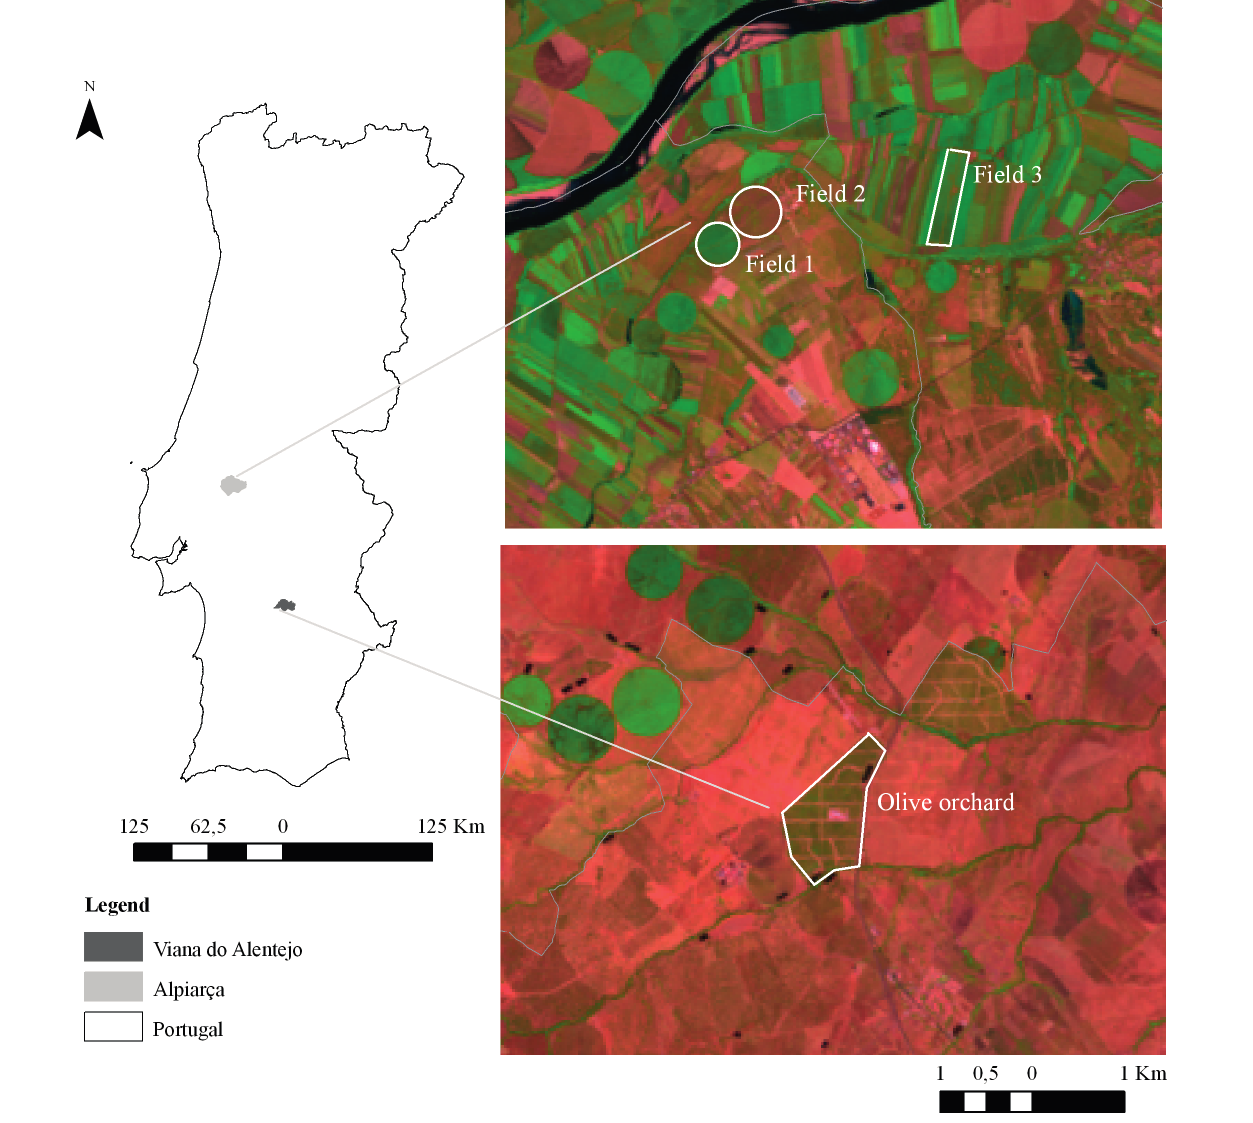
Figure 1. Study areas location in Viana do Alentejo and Alpiarça,